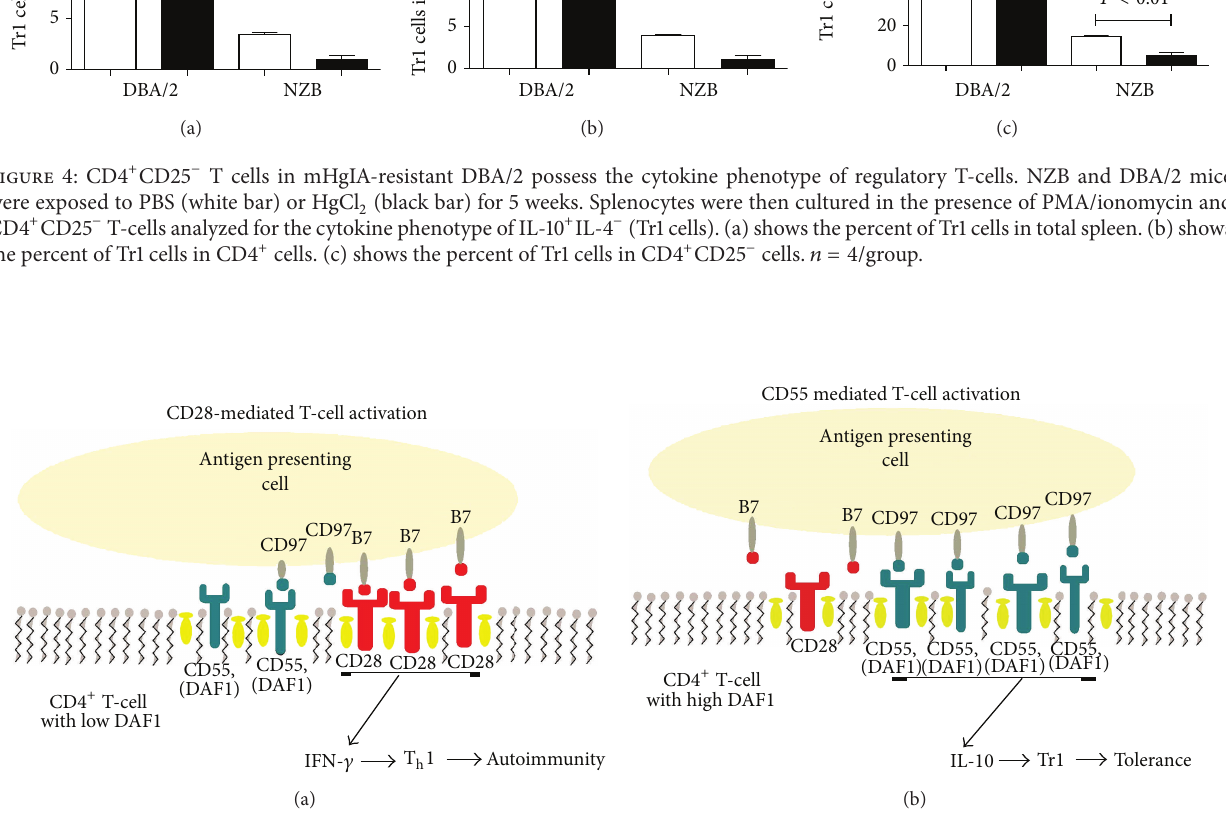
Figure 5: Hypothetical DAF function during T-cell costimulation. Conventional T-cell activation via CD28 cross-linking leads to the formation of lipid raft clusters which exclude CD55 (a) resulting in proinflammatory (i.e., IFN- 𝛾 ) cytokine production which, under suitable conditions, may lead to T h 1-mediated autoimmunity such as mHgIA. Conversely, increasing the surface density of DAF leads to less efficient CD28-mediated T cell activation (b) and in the presence of CD97 potentiates CD55 signaling leading to increased production of IL-10, a T regulatory cell phenotype and immune